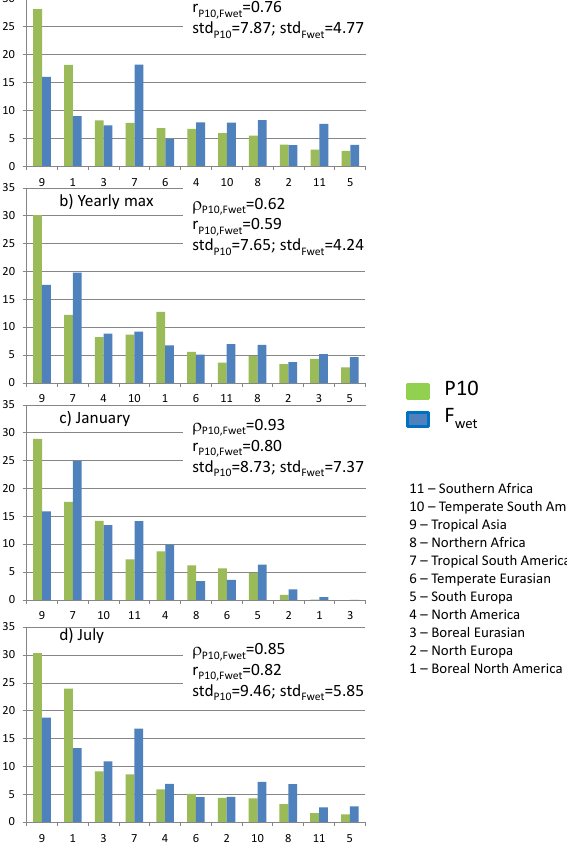
Fig. 5. Relative contribution of each region (see Fig. 2 for the re- gions definition) to the global inundated/saturated area, both for the yearly mean (a) , for annual maximum (b) , mean January (c) and mean July (d) over 1993–2004. For each part of the Fig. 5, the re- gions are ranged in descending order of contribution to global in- undation (P10). The Pearson (Spearman) correlation between the global distribution among the different regions of P10 and F wet , r P10 ,F wet ,(ρ P10 ,F wet ) , is also given for each panel ( a, b, c, and d ). The spatial standard deviation among the different regions for P10 and F wet (std P 10 and std Fwet respectively) is indicated for (a, b, c) and (d) .